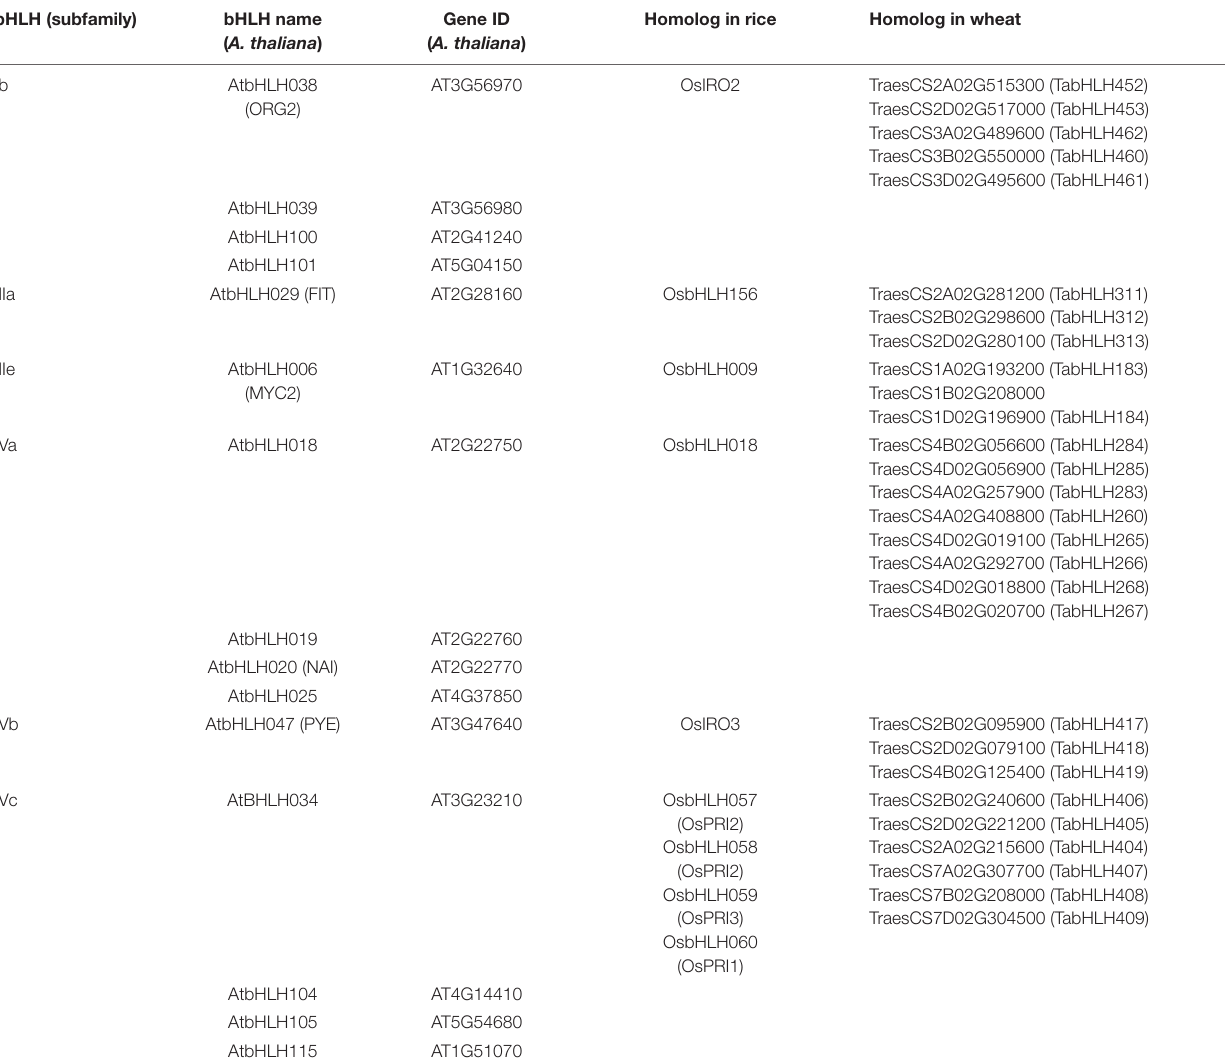
TABLE 2 | Fe homeostasis-related regulatory bHLH protein from A. thaliana and their homologs from rice and wheat. bHLH (subfamily) bHLH name Gene ID Homolog in rice Homolog in ( A. thaliana ) ( A. thaliana )